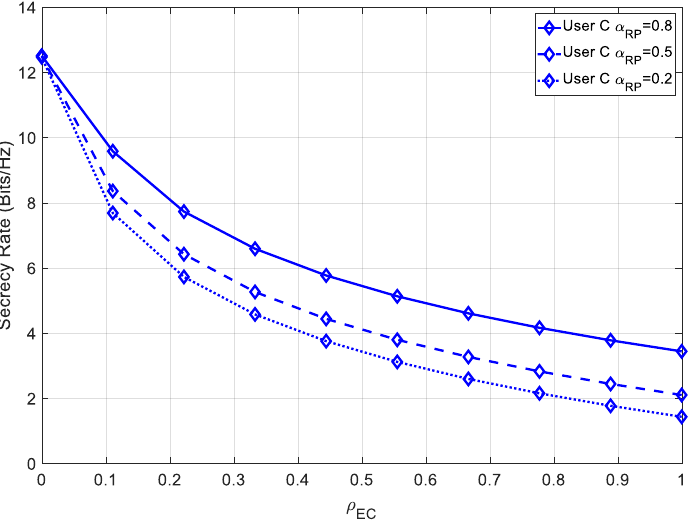
Figure 13. Secrecy rate of the 8 × 8 LOS receiver C with perfect channel estimation and varying ray power